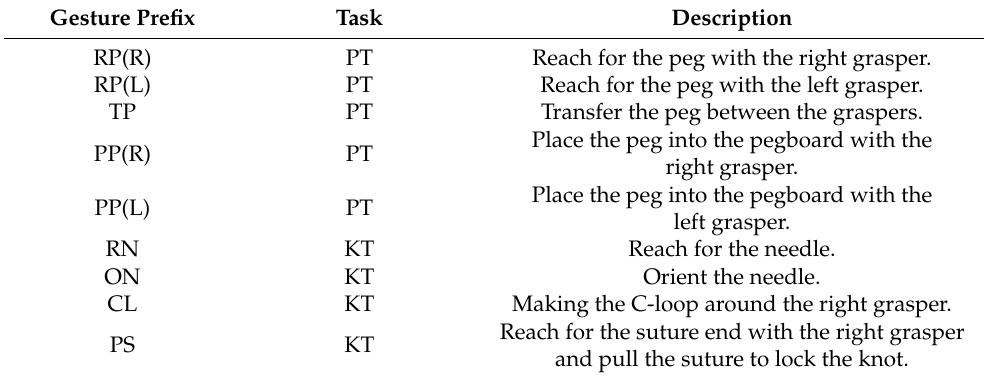
Table 1. Gesture description.